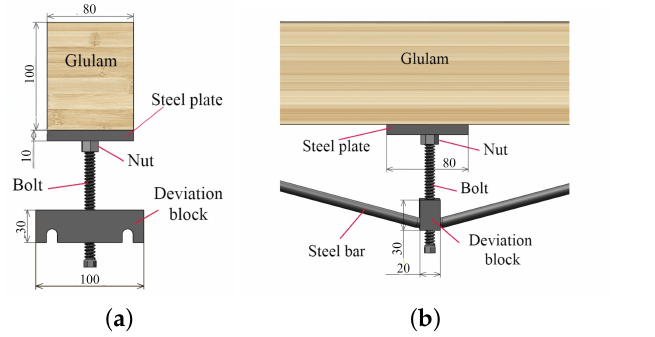
Figure 1. Prestressed beam.